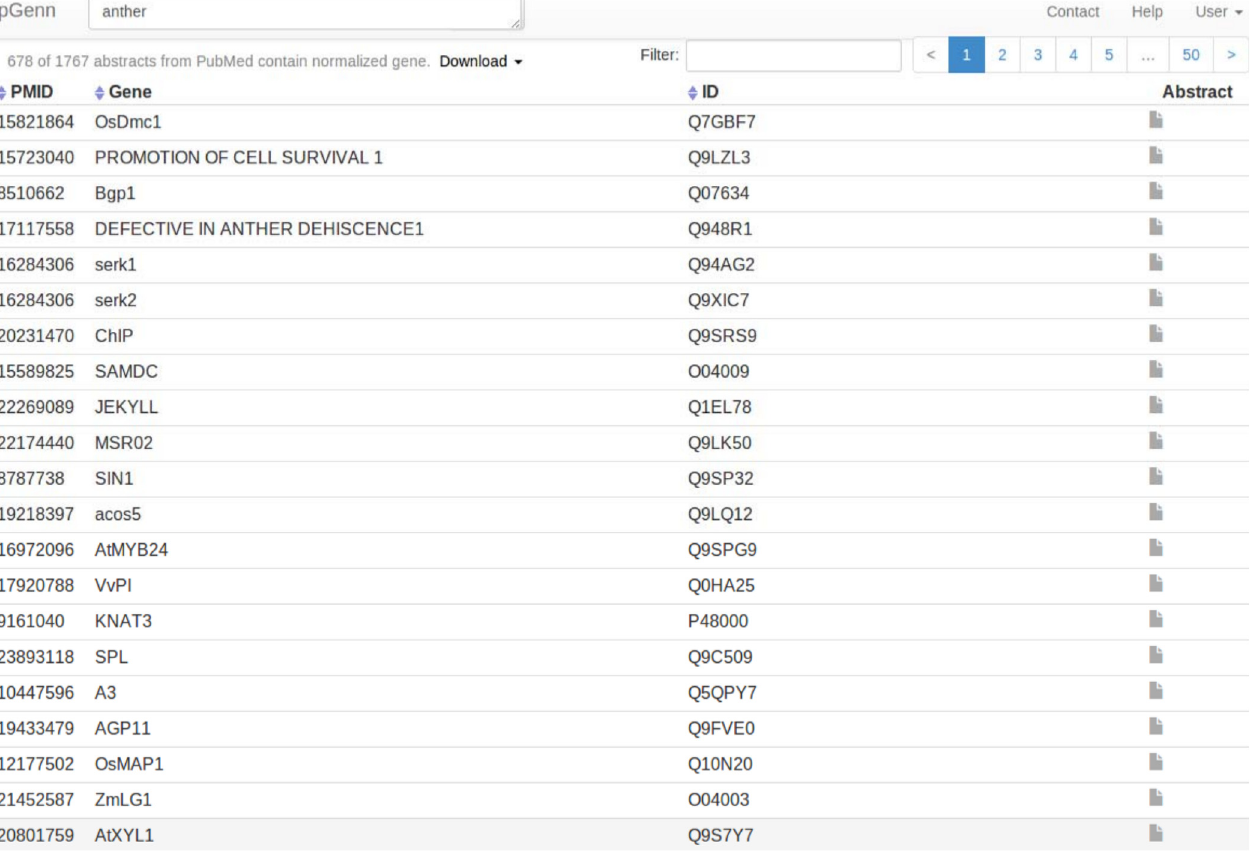
Fig 6. Screenshot of pGenN result